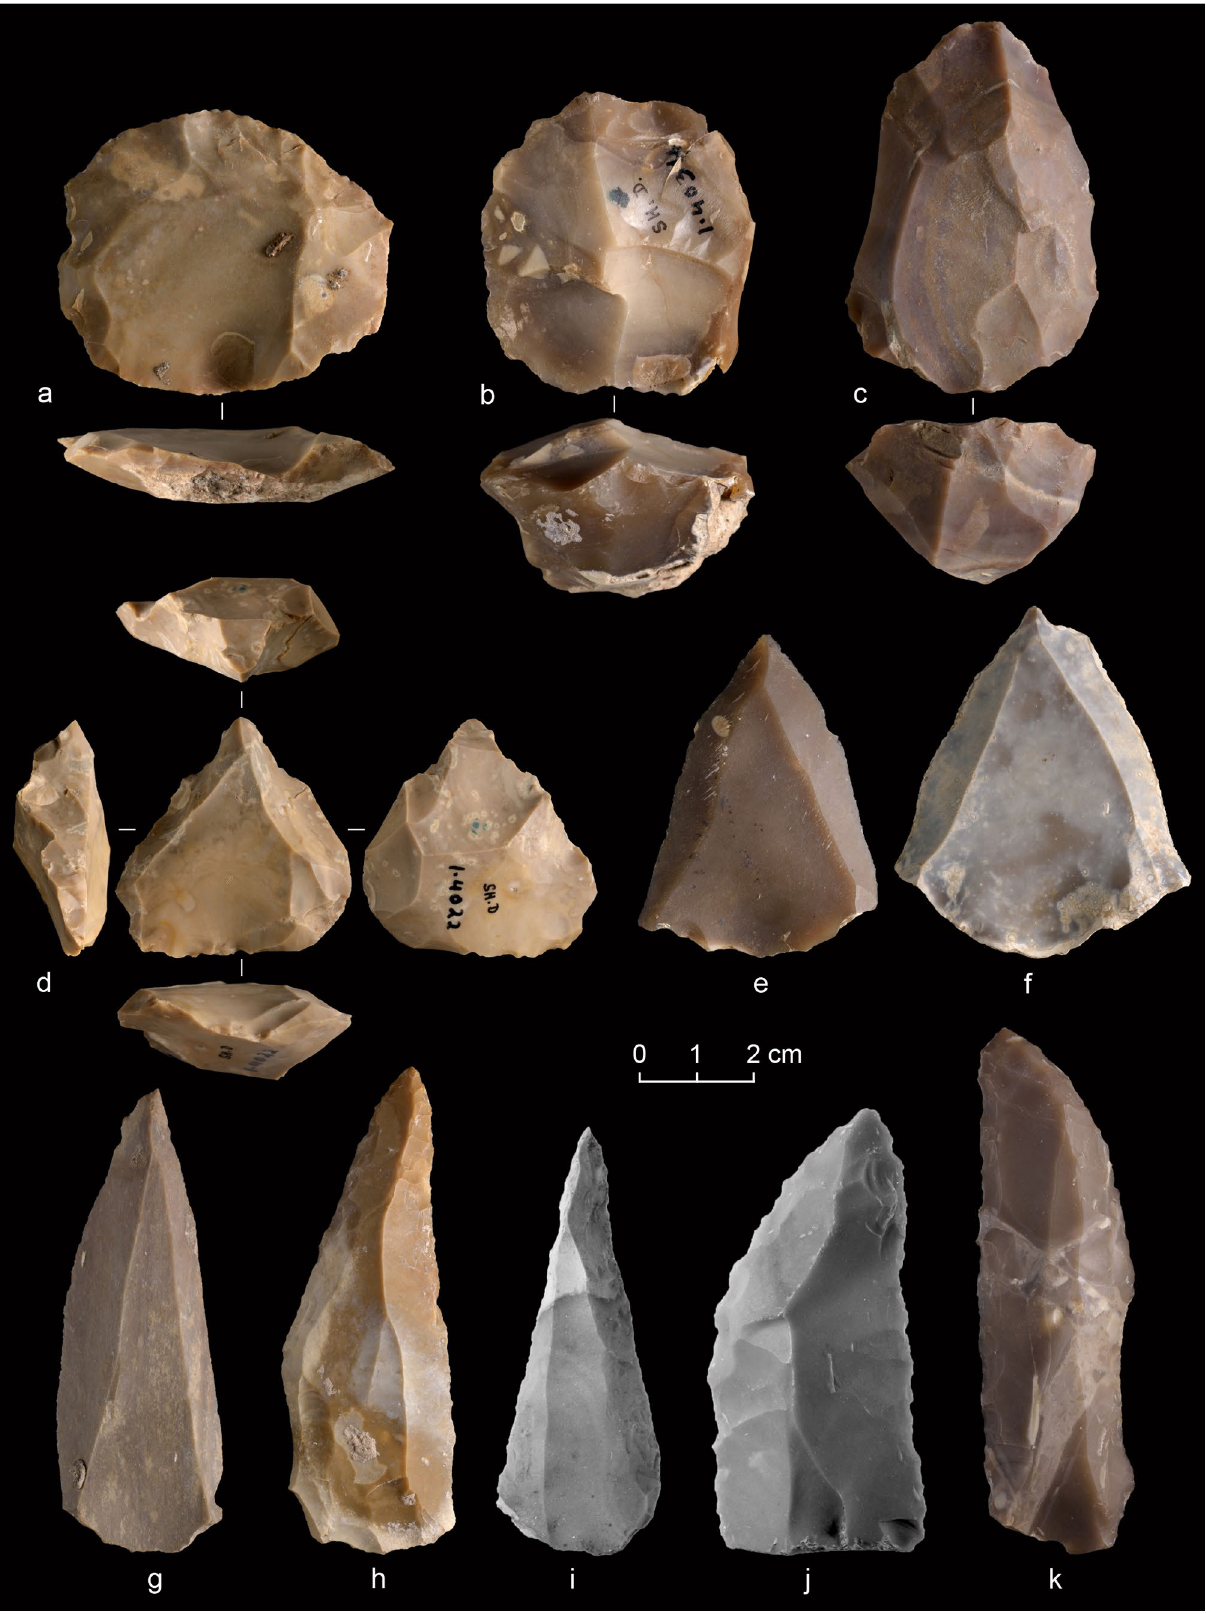
Figure 2. Middle Palaeolithic lithic artefacts from Shukbah Layer D: ( a ) preferential centripetally prepared Levallois core, ( b ) recurrent centripetal Levallois core; ( c ) bidirectional Levallois core; ( d ) exhausted preferential centripetally prepared Levallois core; ( e–g ) Levallois points; ( h–i ) Hummal points; ( j–k ) convergent scrapers on